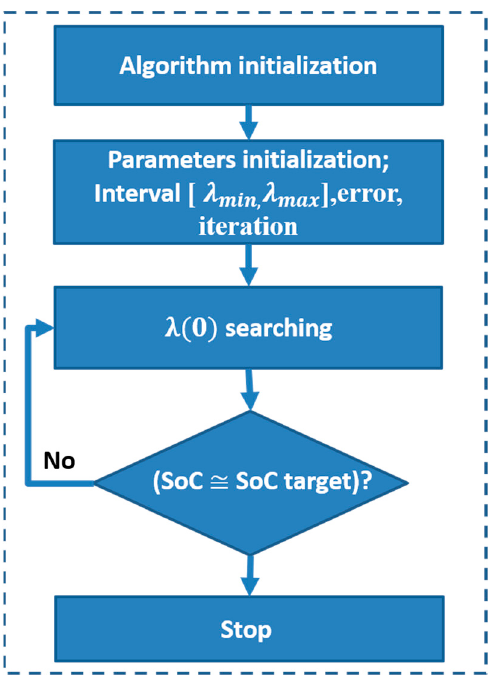
Figure 8. Diagram of an offline L-Control calculation using the Bisection method.